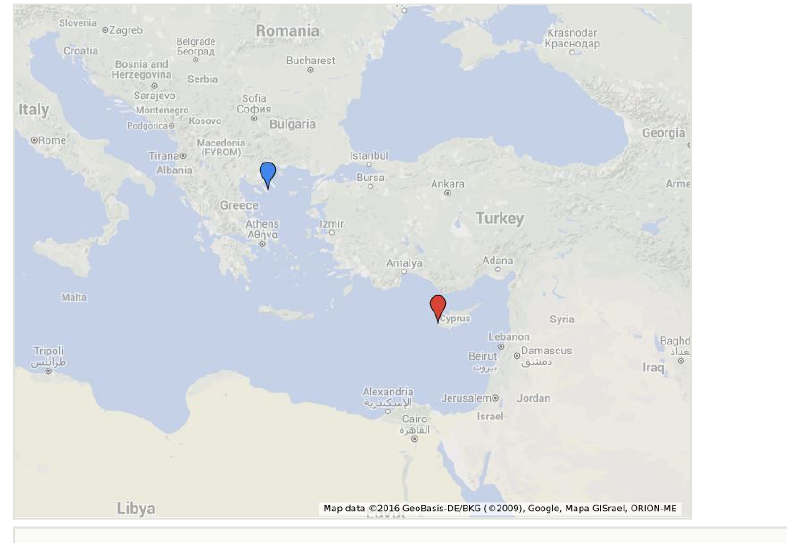
Geographical location of the study area indicating the sampling stations.